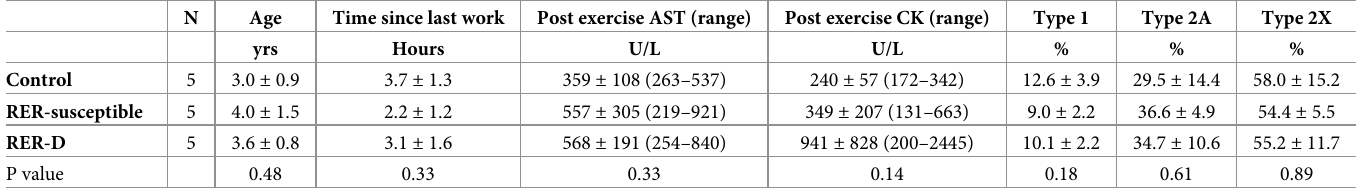
The mean (SD) age, sex, time lapse between exercise and muscle biopsy, plasma aspartate transaminase (AST) and creatine kinase (CK) activities at time of biopsy, and percentage of gluteal muscle type 1, 2A and 2X fibers are shown. There were no significant differences in any parameters between control, RER-susceptible and RER-D